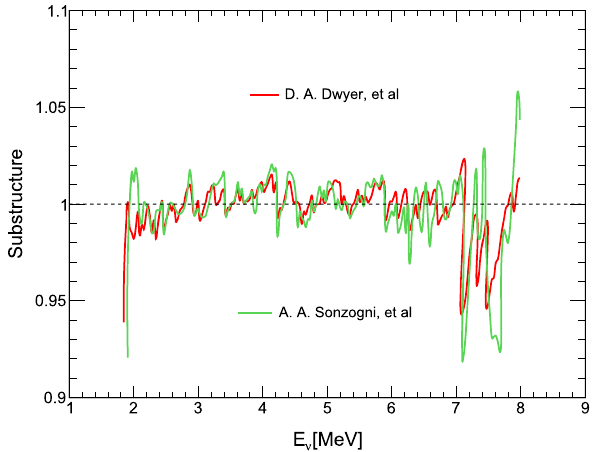
Fig. 7 The estimated scale of fine structure from two additional sum- mation spectra generated by Dwyer [25] (green curve) and Sonzogni [26] (red